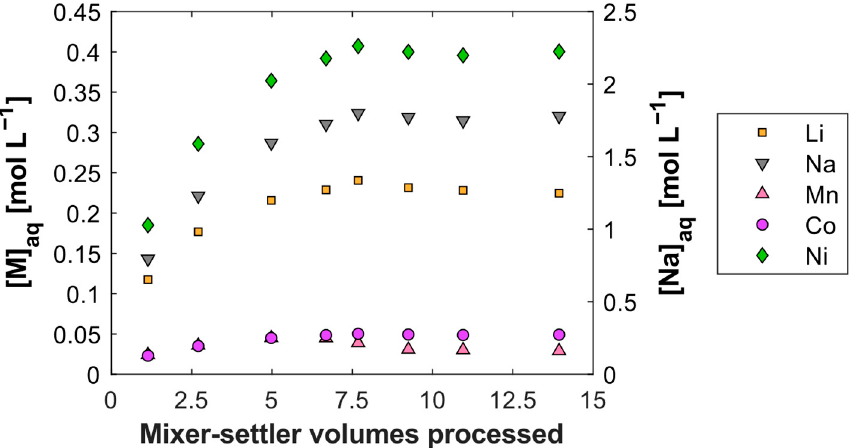
Figure 11. Metal concentrations in the raffinate during continuous stripping of 0.8 M NCM- D2EHPA with 3 M H 2 SO 4 . T = 21 ± 1 °C, S/F = 10; τ mix = 7.3 min. [Li] 0,org = 55.2 mmol L − 1 , [Ni] 0,org =